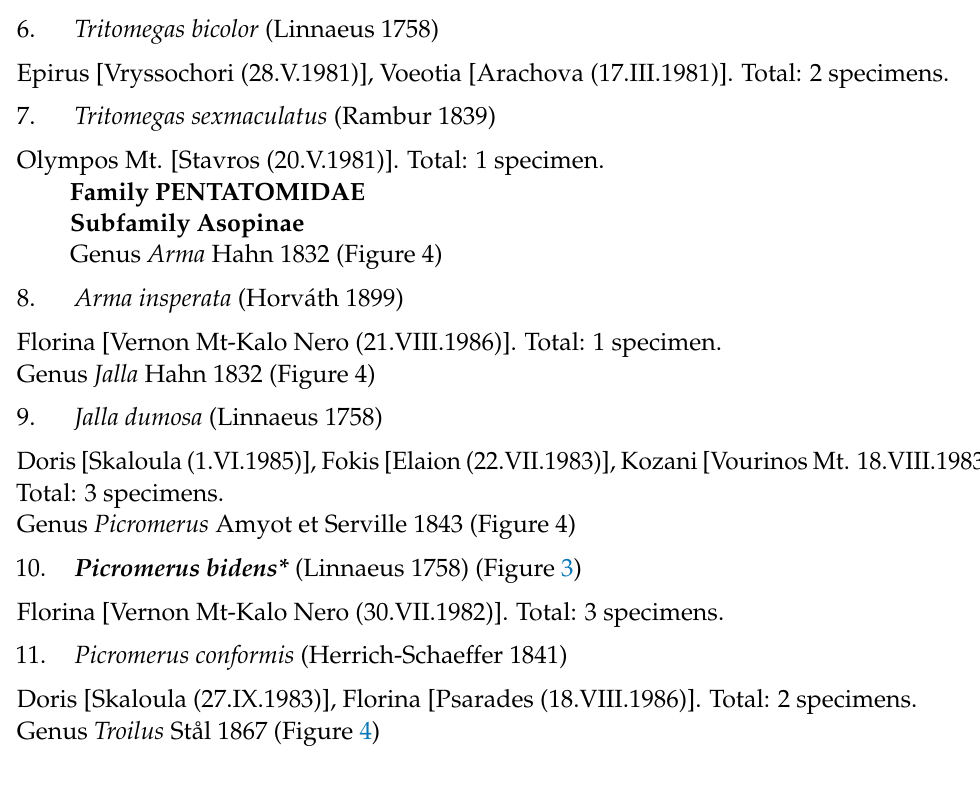
Figure 2. Map showing collecting sites of species of genera Cydnus, Macroscytus, Ochetostethus and Tritomegas during the present study in